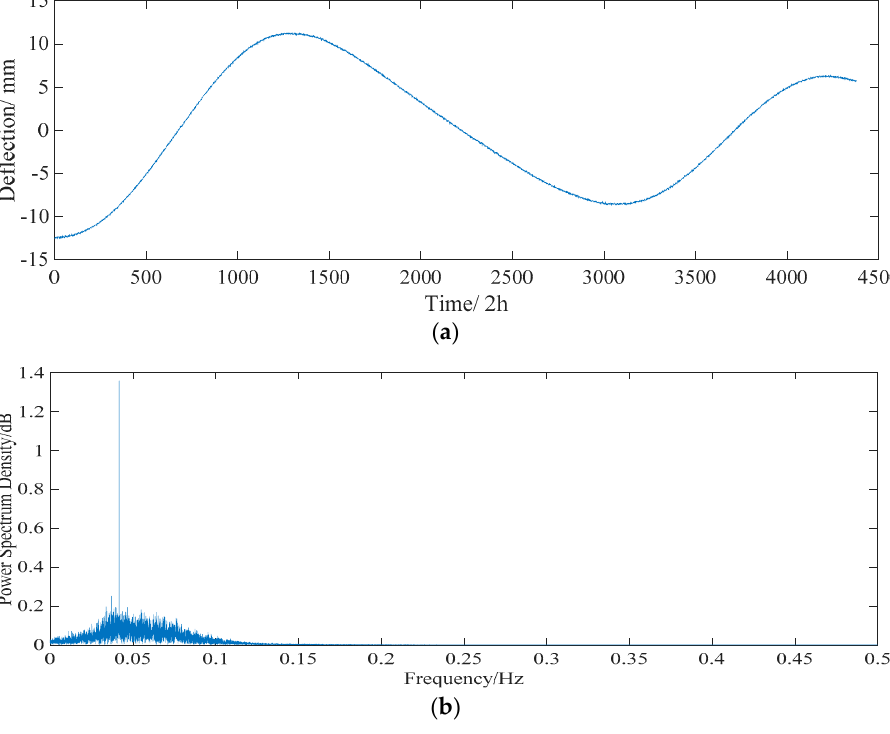
Figure 18. Separated annual temperature deflection effect. ( a ) Time history data. ( b ) Power spectrogram.